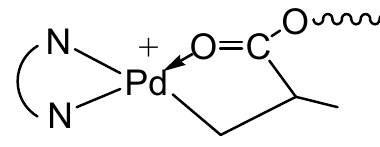
Scheme 2. The five-membered chelate isomer.